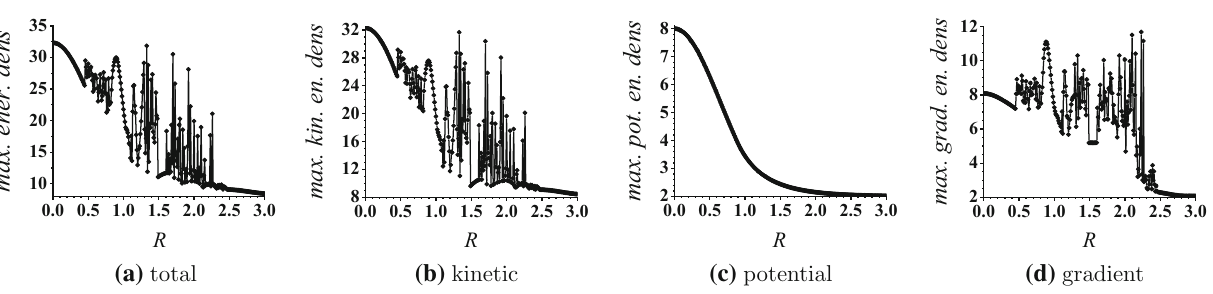
Fig. 4 Space-time picture of the kink–antikink collisions for different R ’s